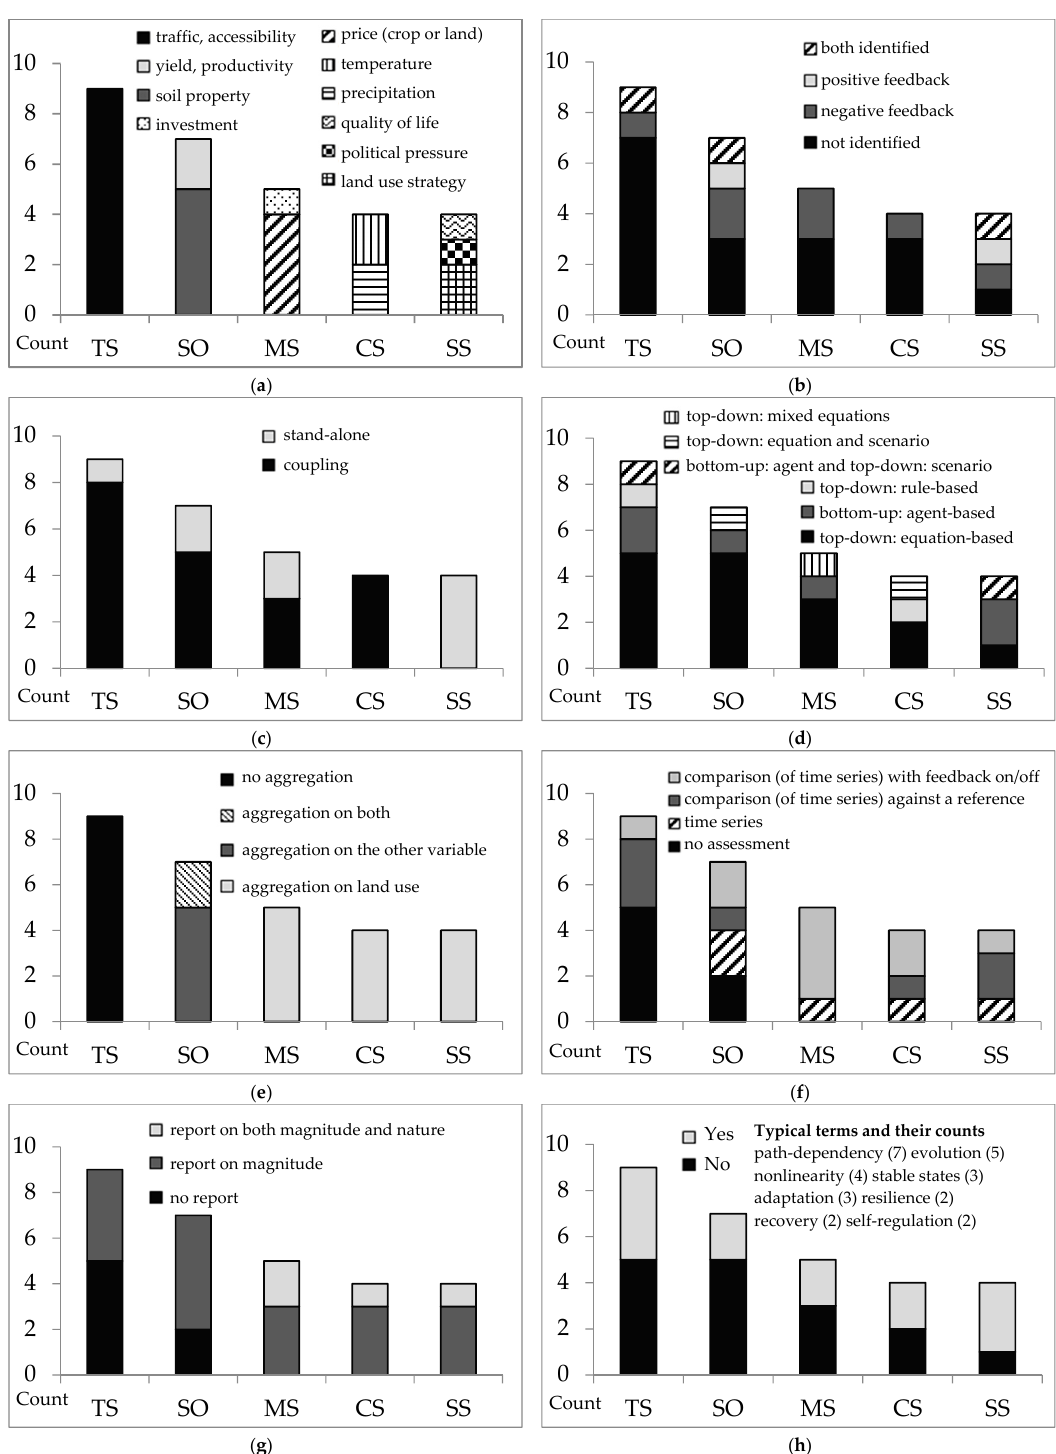
Figure 3. ( a – h ). Representation of feedbacks in the reviewed models, according to the related systems addressed. Note (1) TS: transport system, SO: soil system, MS: market system, CS: climate system, and SS: social system; (2) Cases that discussed feedbacks only conceptually without implementing them in a computational model are omitted. ( a ) major ‘variables linked’; ( b ) feedback character; ( c ) how feedbacks were made operational; ( d ) modelling techniques; ( e ) discretisation of space; ( f ) assessment of feedback effects on the land system; ( g ) classification of reported land system response; ( h ) use of complex system terms to describe model outcome.